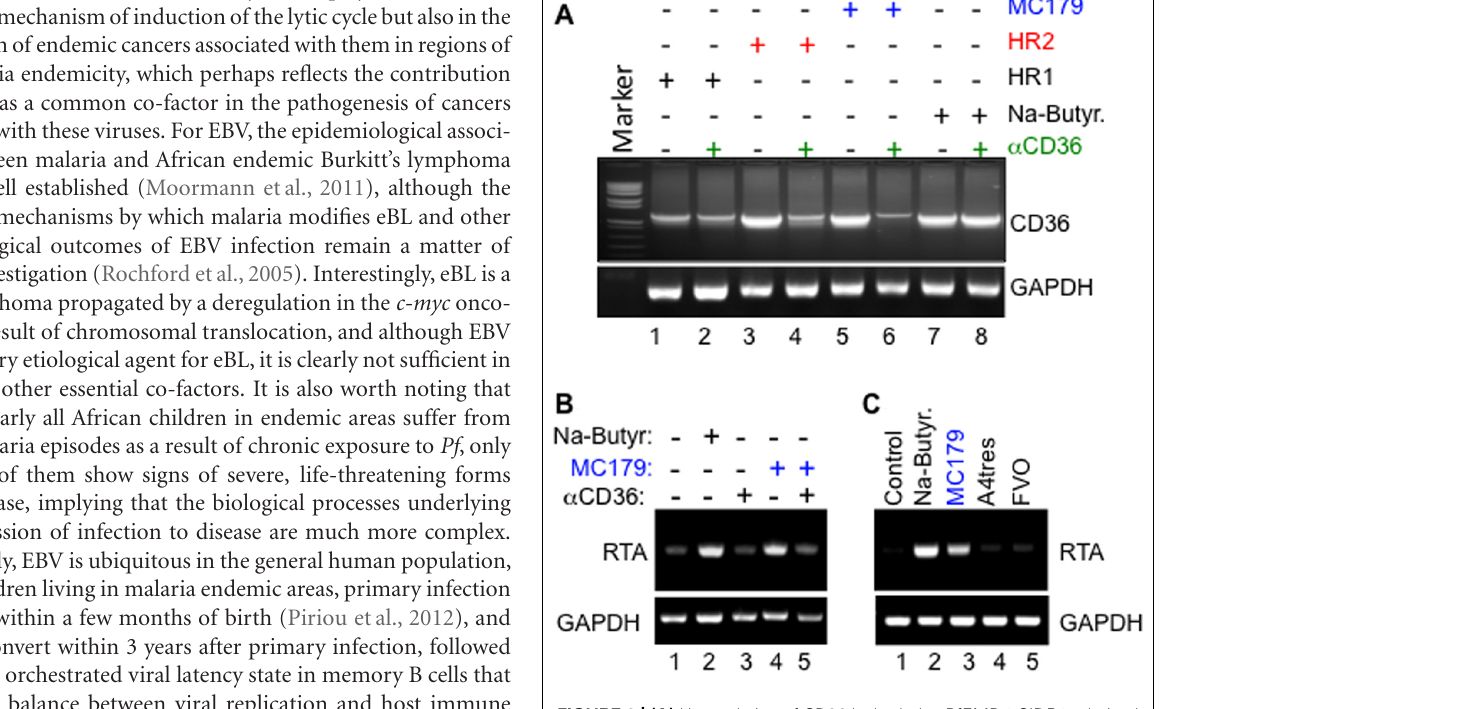
FIGURE 2 | (A) Upregulation of CD36 by both the Pf EMP-1-CIDR1 α -derived MC179 peptide (lanes 5 and 6) and by KSHV gB-derived heptad peptide ligands HR2 (lanes 3 and 4), and the less potent HR1 (lanes 1 and 2) are both blocked by a monoclonal anti-CD36 antibody. Note that anti-CD36 did not block control upregulation of CD36 in response to treatment with sodium butyrate (NaB; lanes 7 and 8). (B) Activation of KSHV RTA by MC179 occurs via a CD36-dependent mechanism that can be blocked by anti-CD36 antibody FA6-152. Methodology : briefly, melanoma-derived Mel1700 cells were seeded in a six-well plate and either left untreated or pre-incubated with 10 μ g/ml of anti-CD36 monoclonal antibody clone FA6-152 for 25 min. at 25 ◦ C. After washing to remove excess antibody, cells were incubated with either 100 μ g/ml of KSHV gB-derived HR1, 200 μ g/ml HR2 peptide, 100 μ g/ml recombinant MC179, or 2 mM sodium butyrate (NaB). Forty-eight hours after treatment, total RNA was isolated and used as template in semi-quantitative RT-PCR with primers to an internal fragment of human CD36, viral RTA, or human glyceraldehyde 3-phosphate dehydrogenase (GAPDH) loading control. (C) Specific activation of the KSHV lytic switch protein, RTA, by the Pf EMP-1-CIDR1 α - derived peptide MC179 from Pf Malayan Camp strain, but not by peptides derived from CIDR1 α domains of A4tres (which binds ICAM-1) or the Vietnam Oak Knoll strain